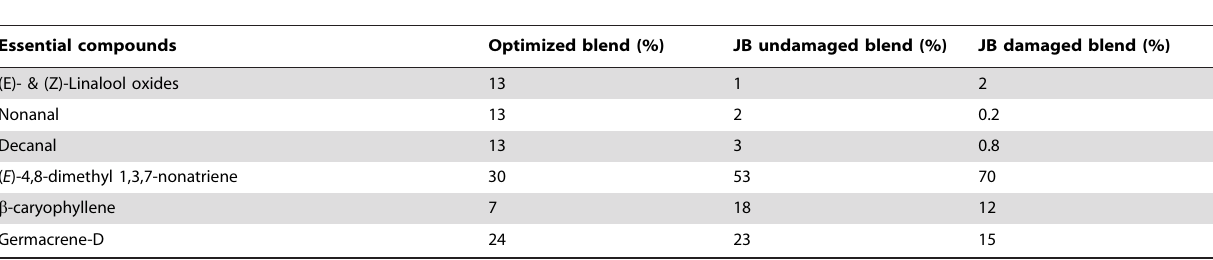
Table 1. The relative ratios (%) of the seven key essential volatile compounds used in three synthetic blends.